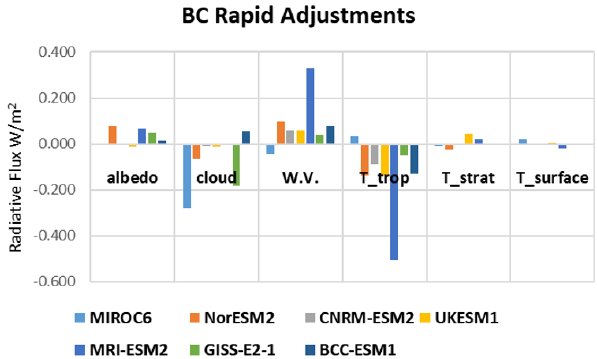
Figure 3. Breakdown of the atmospheric adjustments (albedo, cloud, water vapour, troposphere temperature, stratosphere tem- perature and surface temperature) for the piClim-BC experiments, showing the variability between